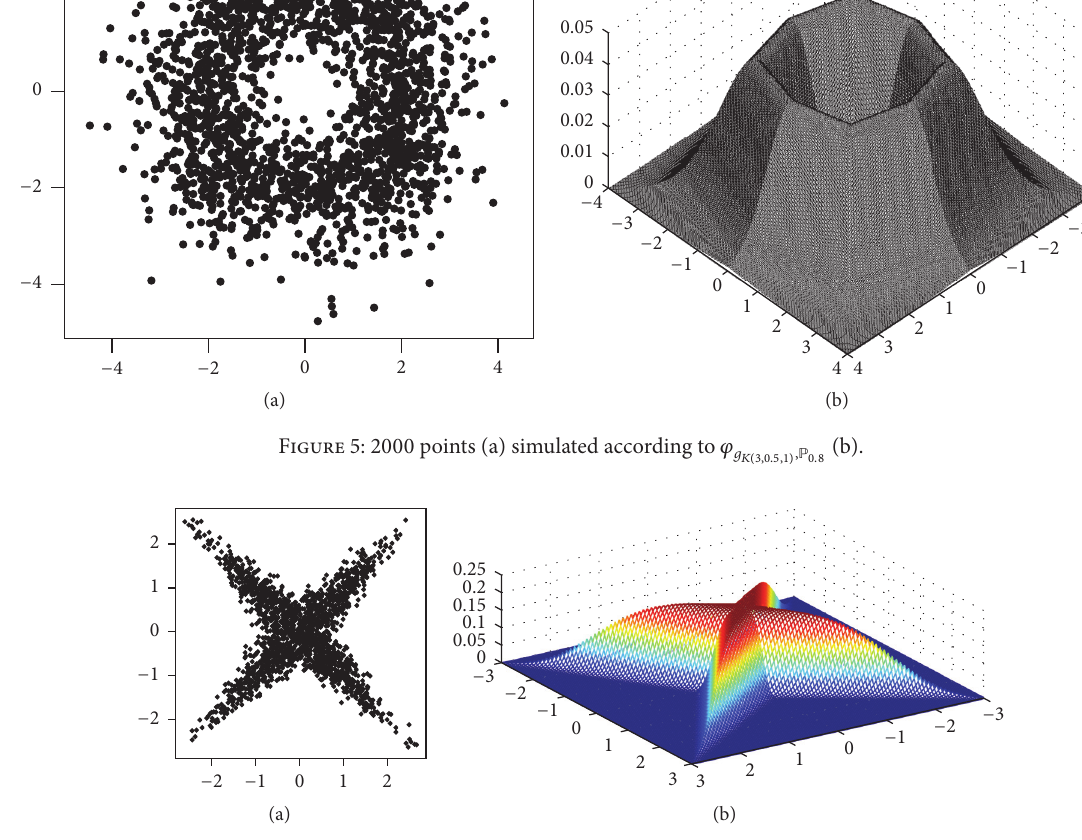
Figure 6: 2000 points (a) simulated according to 𝜑 𝑔